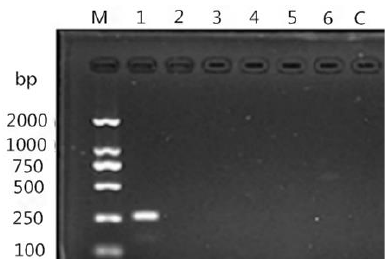
Figure 7. The results of specific PCR for N. oiratianus. M: DNA Marker LD2000; 1: N. oiratianus ; 2: N. longispiculata ; 3: Ostertagia spp. ; 4: Trichostrongylus spp. ; 5: Trichuris spp. ; 6: Haemonchus contortus ; C: blank control .